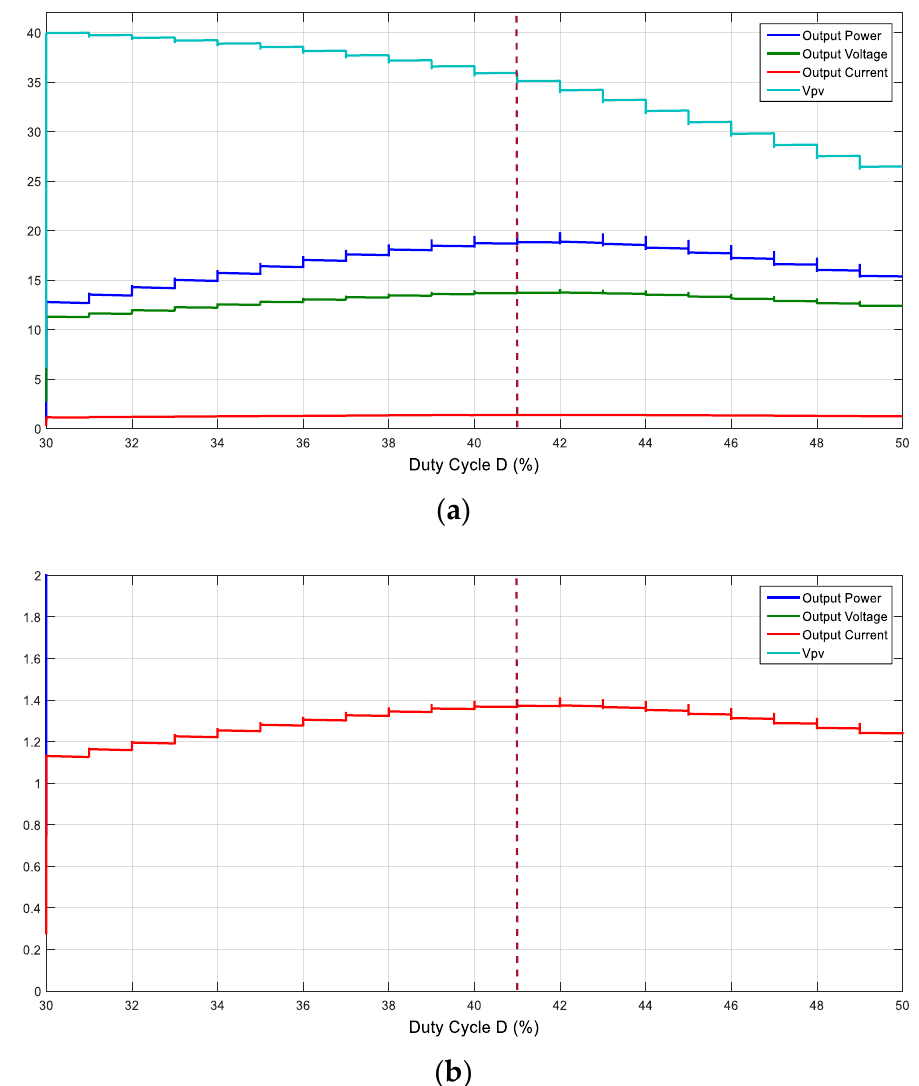
Figure 5. Buck converter: graph of output voltage, output current, output power, and V PV with duty cycle.